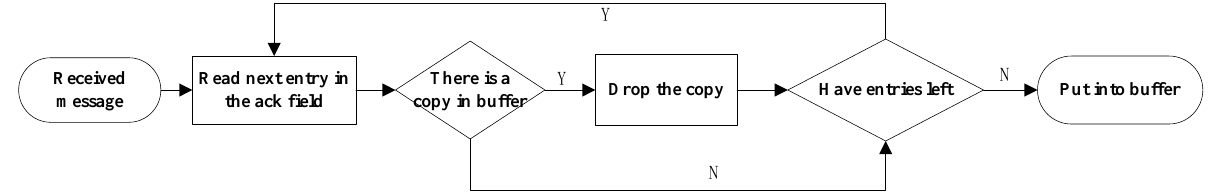
Figure 2. Flow chart of deleting redundant